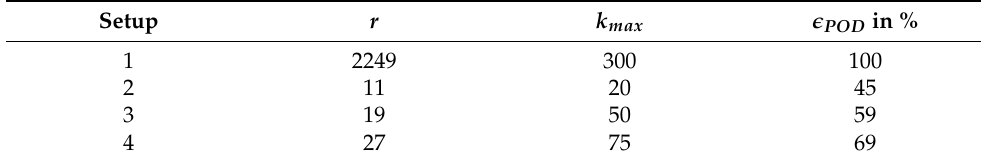
Table 2. Different settings for k -means clustering for the wind turbine